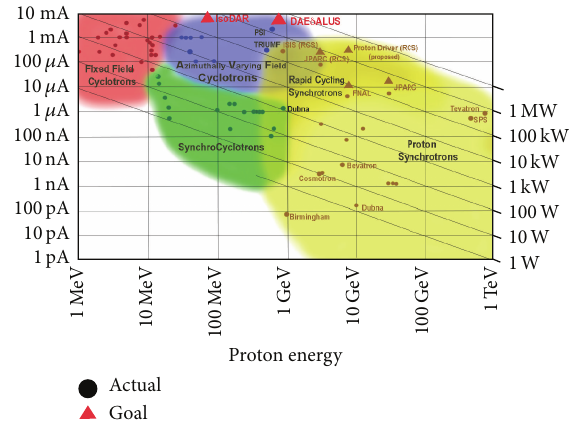
Figure 5: Proton energy versus current for various existing machines. The type of accelerator is indicated. Various types of cyclotronsarenoted,whereFFisthefixedfieldorclassicalcyclotron; FM is the frequency modulation (synchro-) cyclotron; and AVF is the azimuthal varying field cyclotron. This plot is taken from